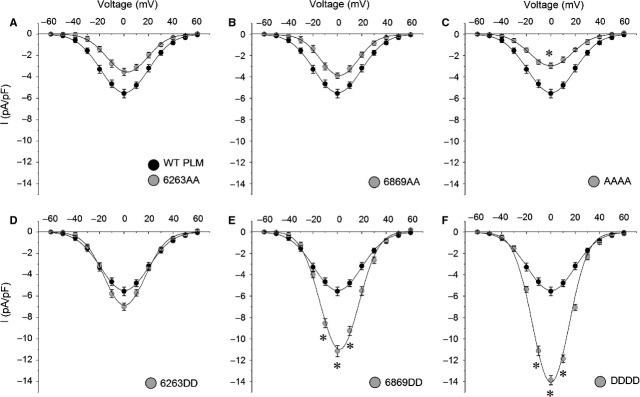
Aspartic acid substitutions within the phosphorylation sites of PLM increase the peak current density. The current-voltage relationship showing the peak current density (Ipeak) was recorded from cells with WT and mutant PLMs (n + 6–10). Ipeak was dramatically increased by PLM phosphomimetic mutants 6263DD, 6869DD, and DDDD and was significantly decreased by the mutant of AAAA, in which the phosphorylation sites were all blocked. * P < 0.05 versusWT PLM. Ba2+ was used as the charge carrier.